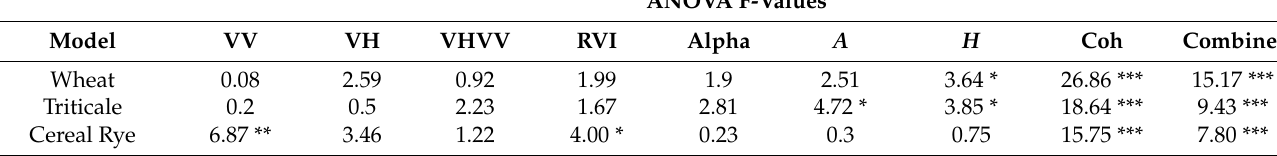
Table 5. Results of combined optical and synthetic aperture radar (SAR) species-specific analysis of variance (ANOVA) models. Models combined the normalized difference red-edge index using band 5 (NDVI_RE1) optical index and SAR backscatter indices and polarimetric parameters. All models are compared to the NDVI_RE1 model with no SAR metrics to evaluate statistically significant im- provements when SAR metrics are included. Combined models varied by species, and all significant combined models included InSAR coherence (Coh). Wheat also included entropy ( H ); triticale also included anisotropy ( A ); and cereal rye included vertical–vertical polarization (VV) and the radar vegetation index (RVI). ANOVA F-Values Model Alpha H Coh Combined Wheat 0.08